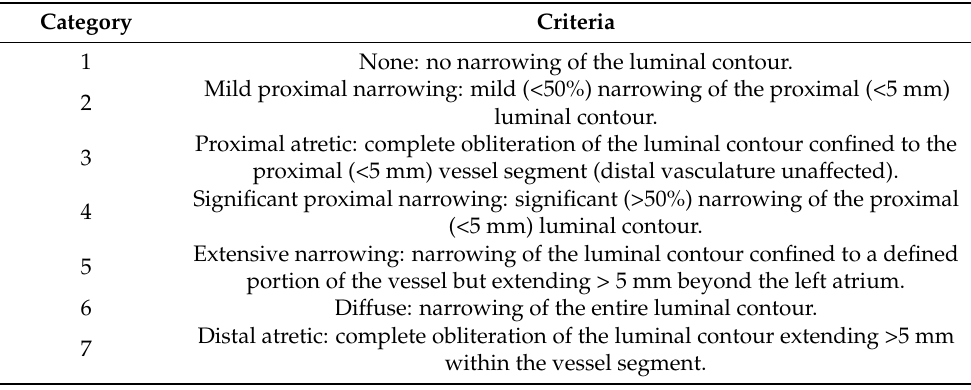
Table 1. Pulmonary vein status categorical